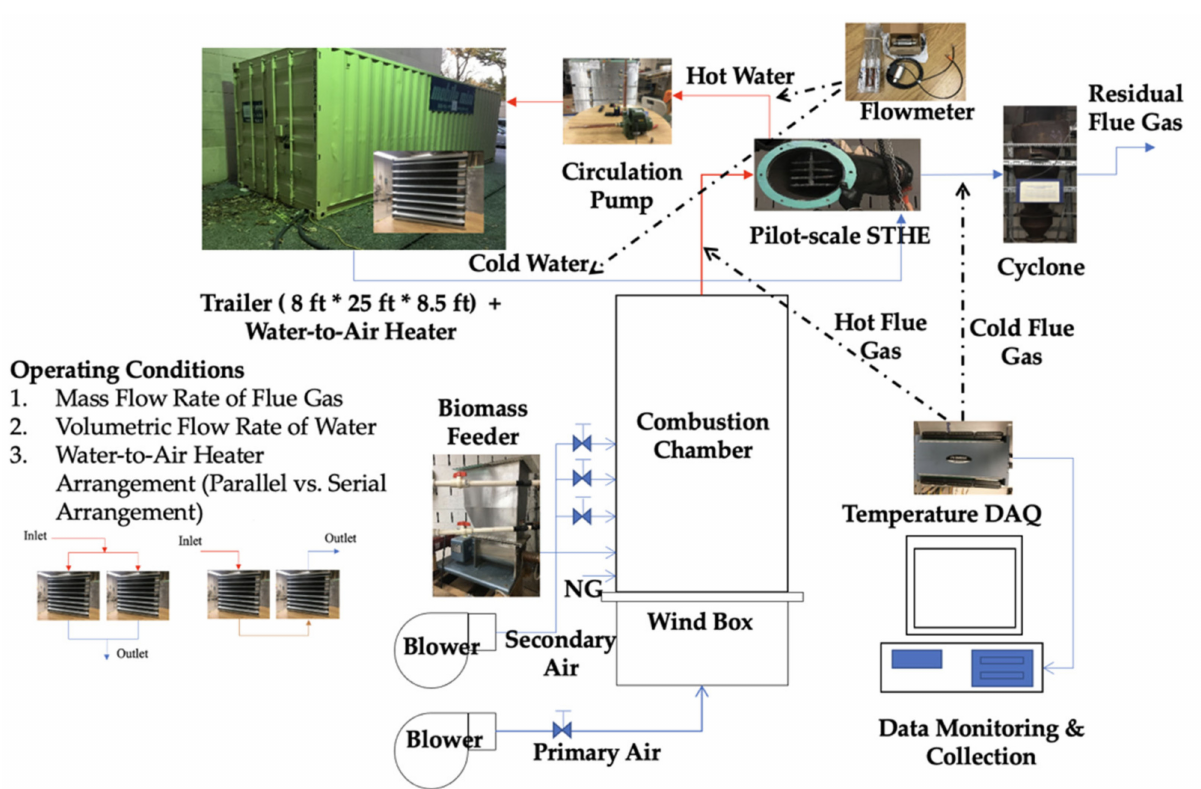
Figure 3. Experimental setup and operating conditions for the pilot-scale STHE system